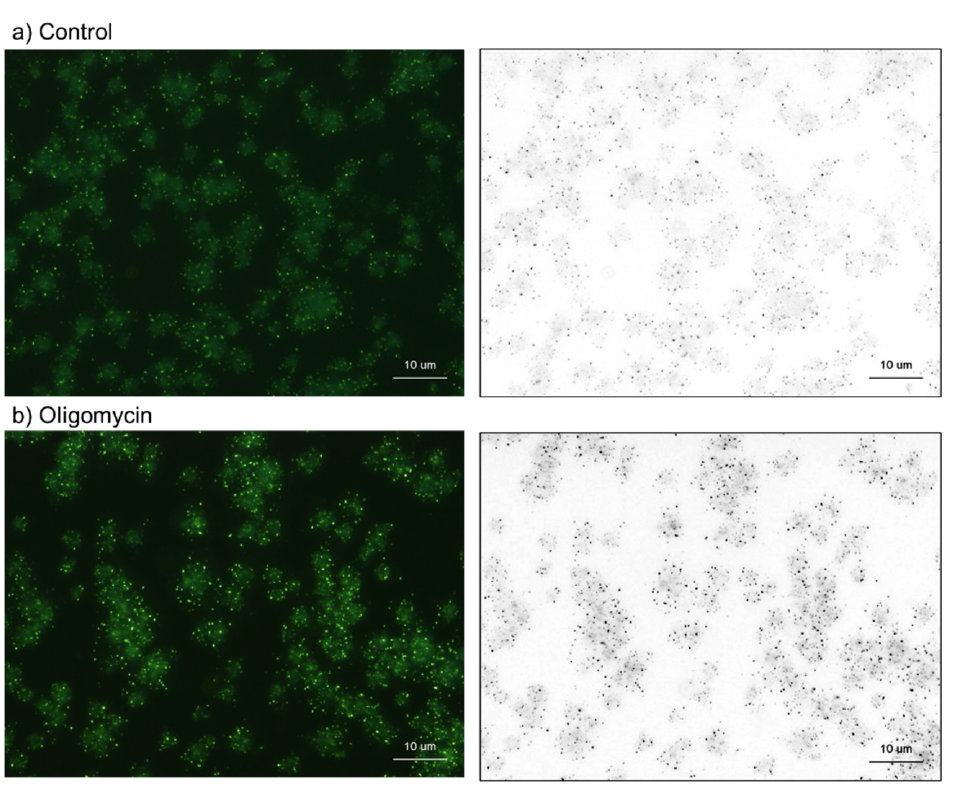
Figure 8. The effects of ALP on platelet polyP. Fixed platelets were treated with 0.3 U/mL (1:10) ALP for 8 h ( b ). The control was incubated in the specific buffer without ALP ( a ). Bar = 10 μ m. Similar results were observed in four other independent experiments.